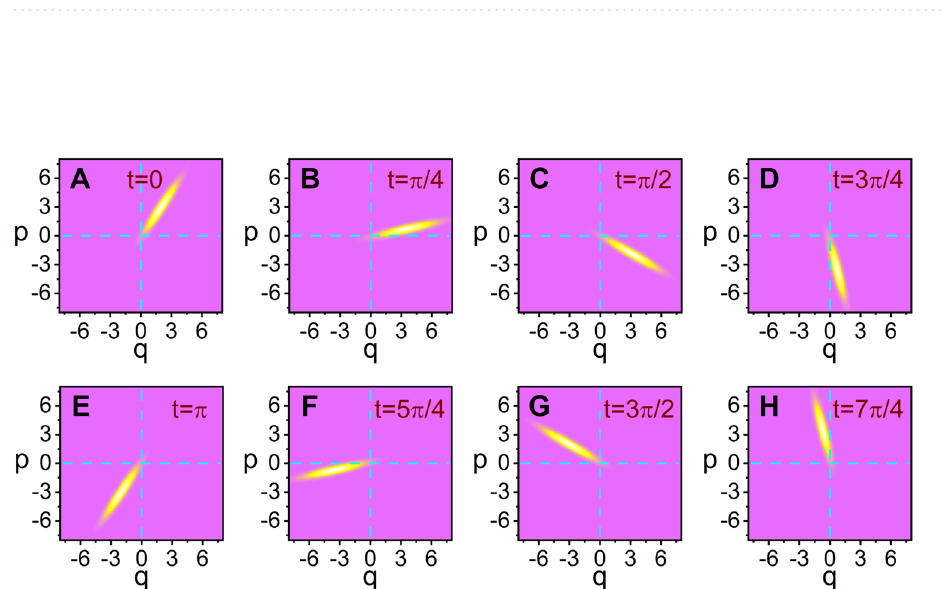
Figure 5. Comparison of the density plot of W for static ( A ) and nonstatic ( B ) light waves at t are chosen as (1, 1) for A and (2, 1) for B. We have used ω